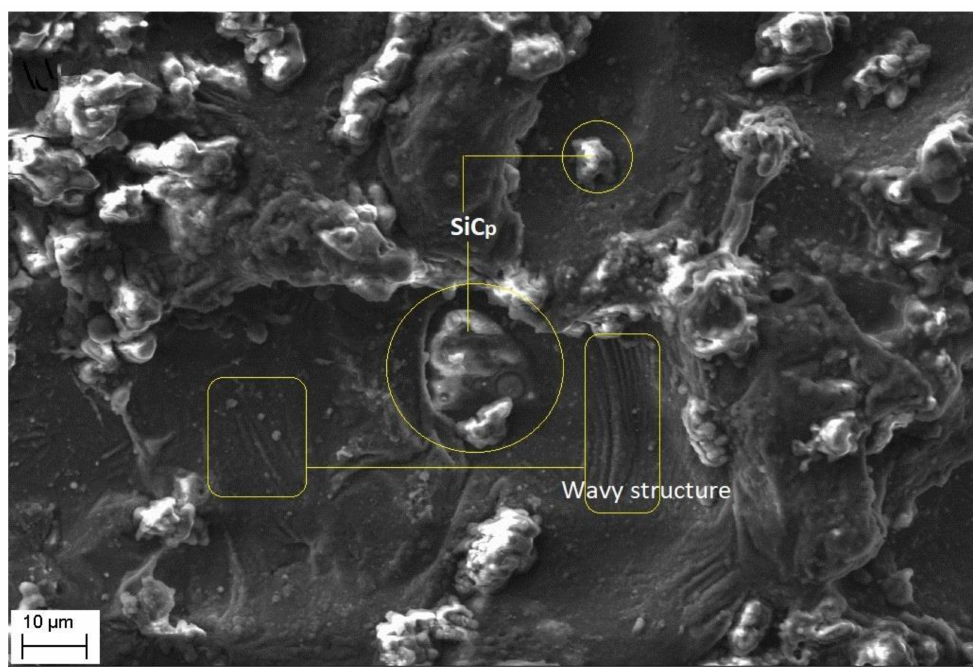
Figure 11. Formation of wavy patter on the crater